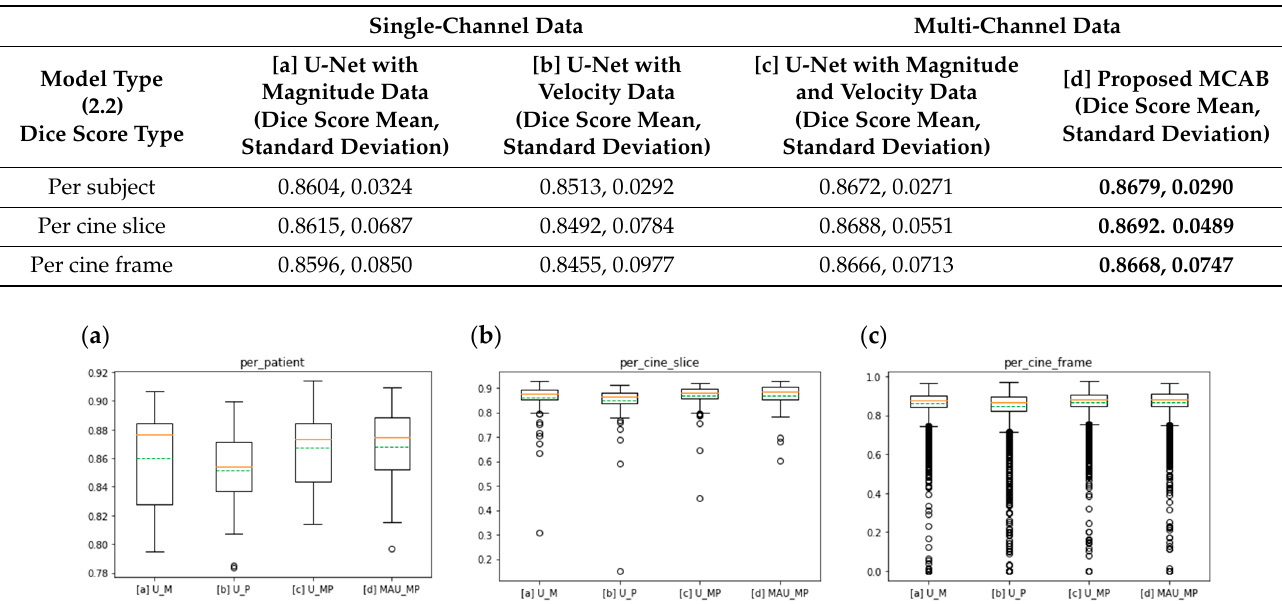
Table 2. Statistics (mean and standard deviation) Dice Scores of different models prior to post-processing (Bold values indicate the best performance).